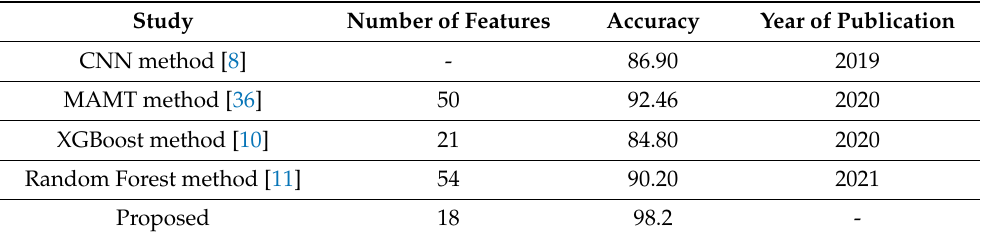
Table 6. Comparison results between this study and other